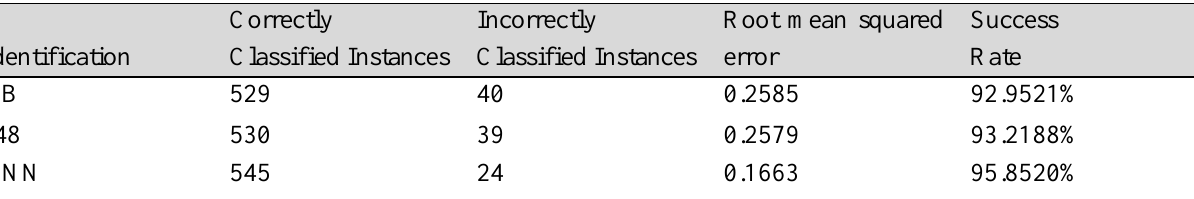
Figure 6. Precision of the three classifiers Table 4. Overall performance for the proposed BC system recognizer